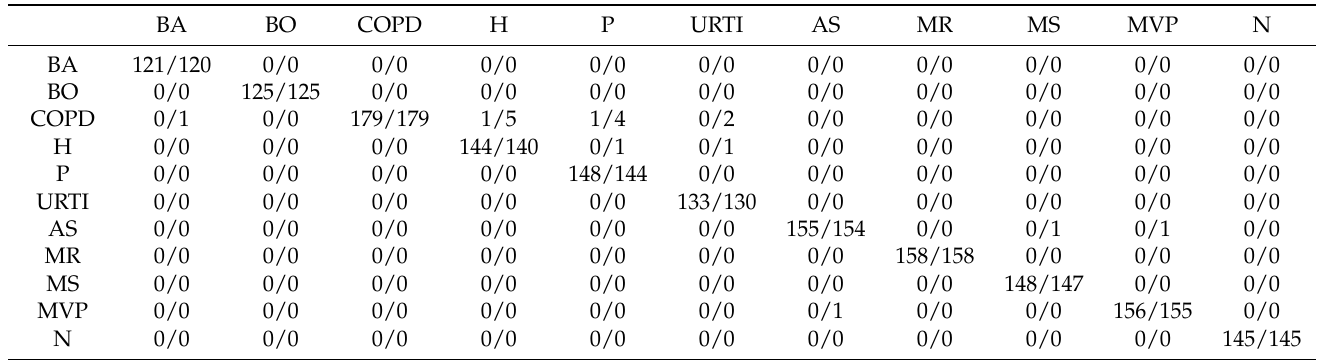
Table 4. Confusion matrix of 11 classes based on 20% of test